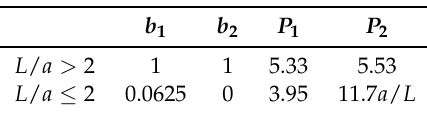
Table 1. Parameters used in Pedersen’s expression of the structure factor of the WLC model for both rigid and flexible